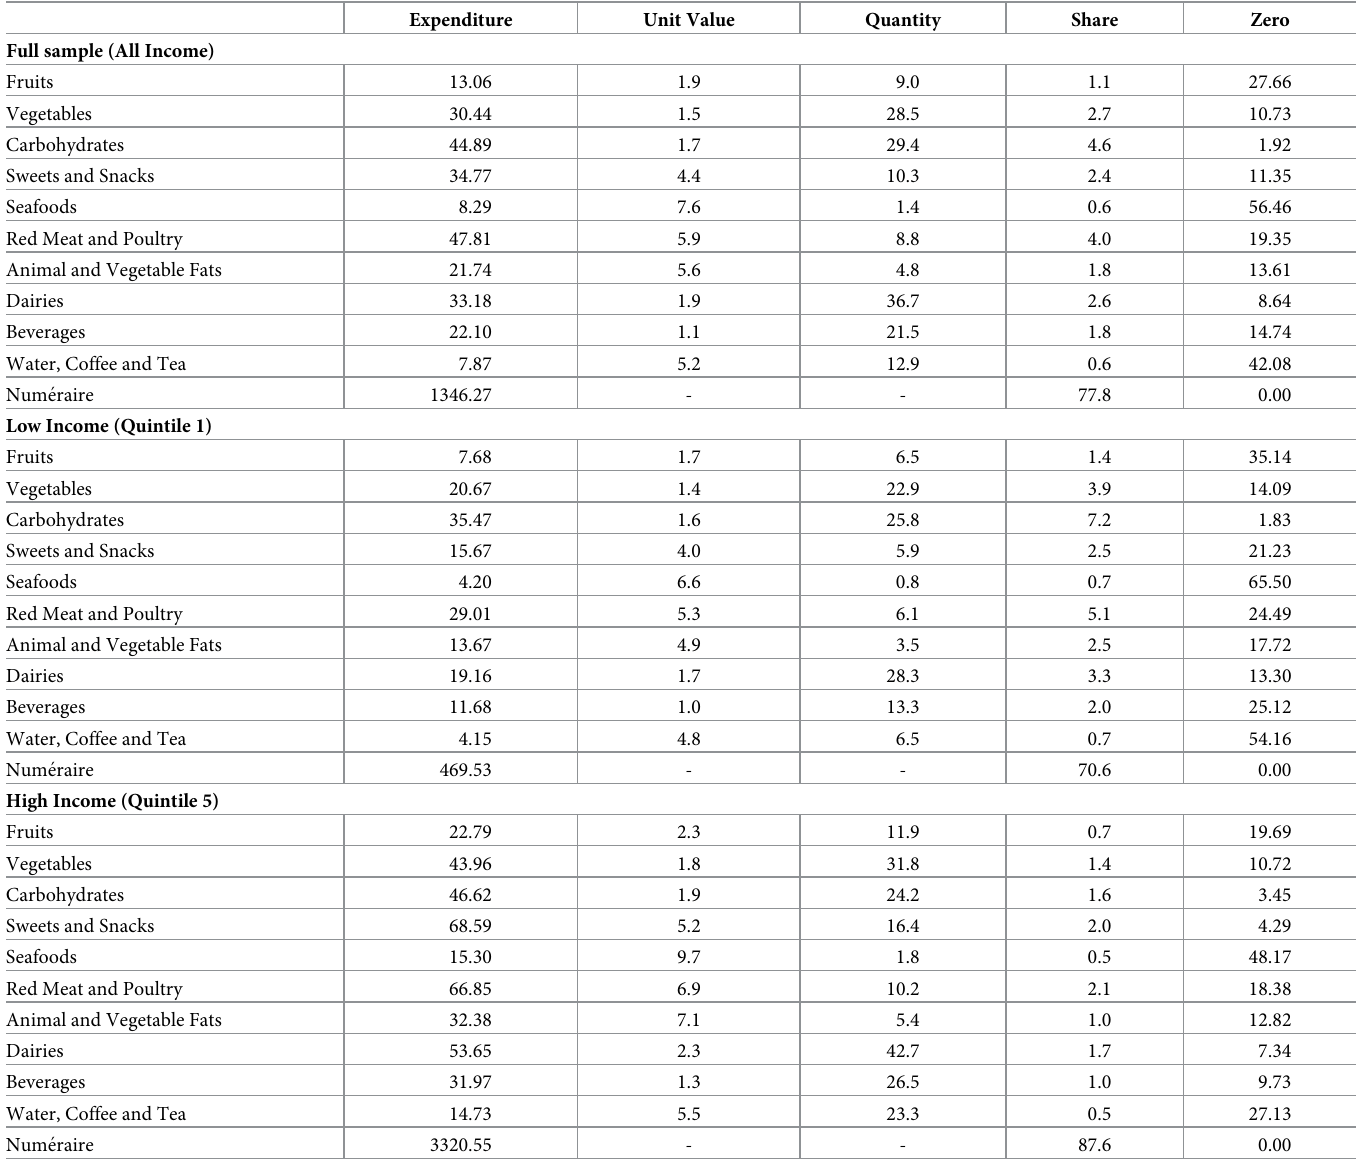
Table 2. Food group statistics by household income